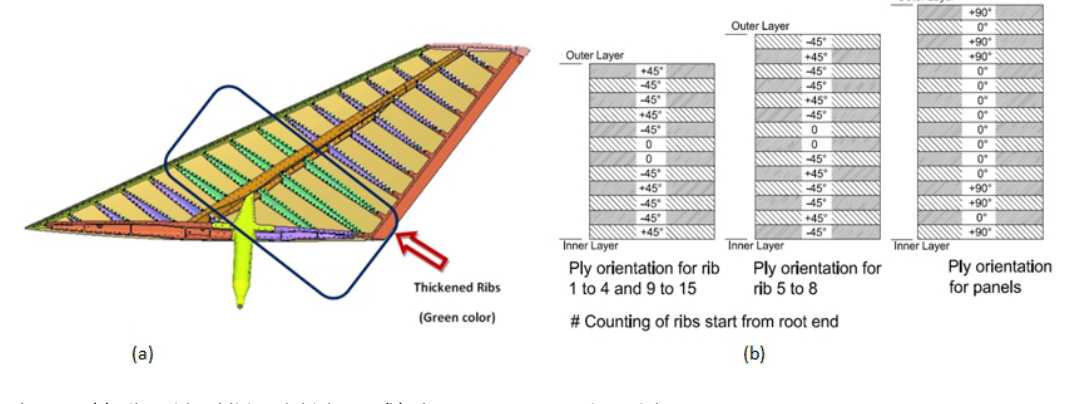
Figure 7: (a) Ribs with additional thickness (b) Ply Sequence on Design-Trial-2